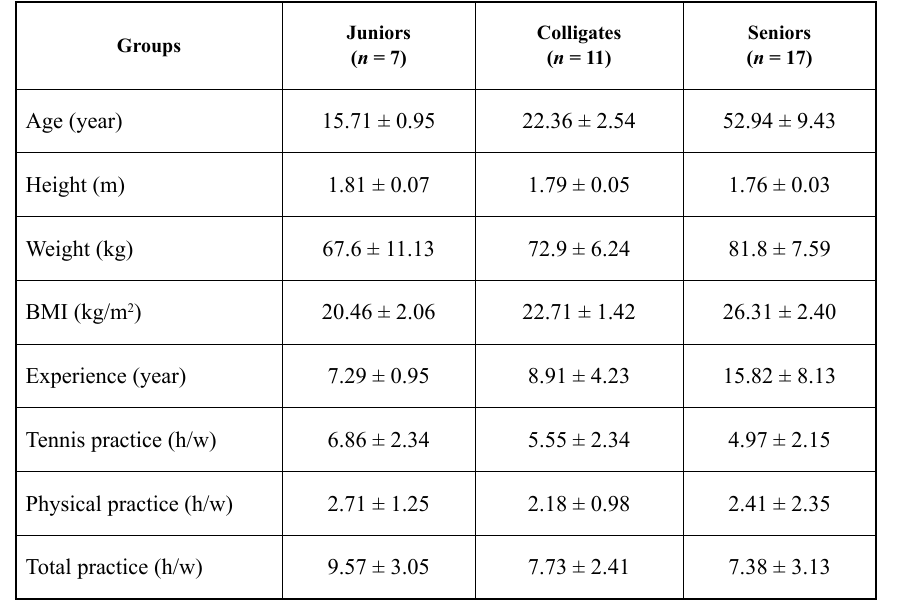
Table 1. Means and standard